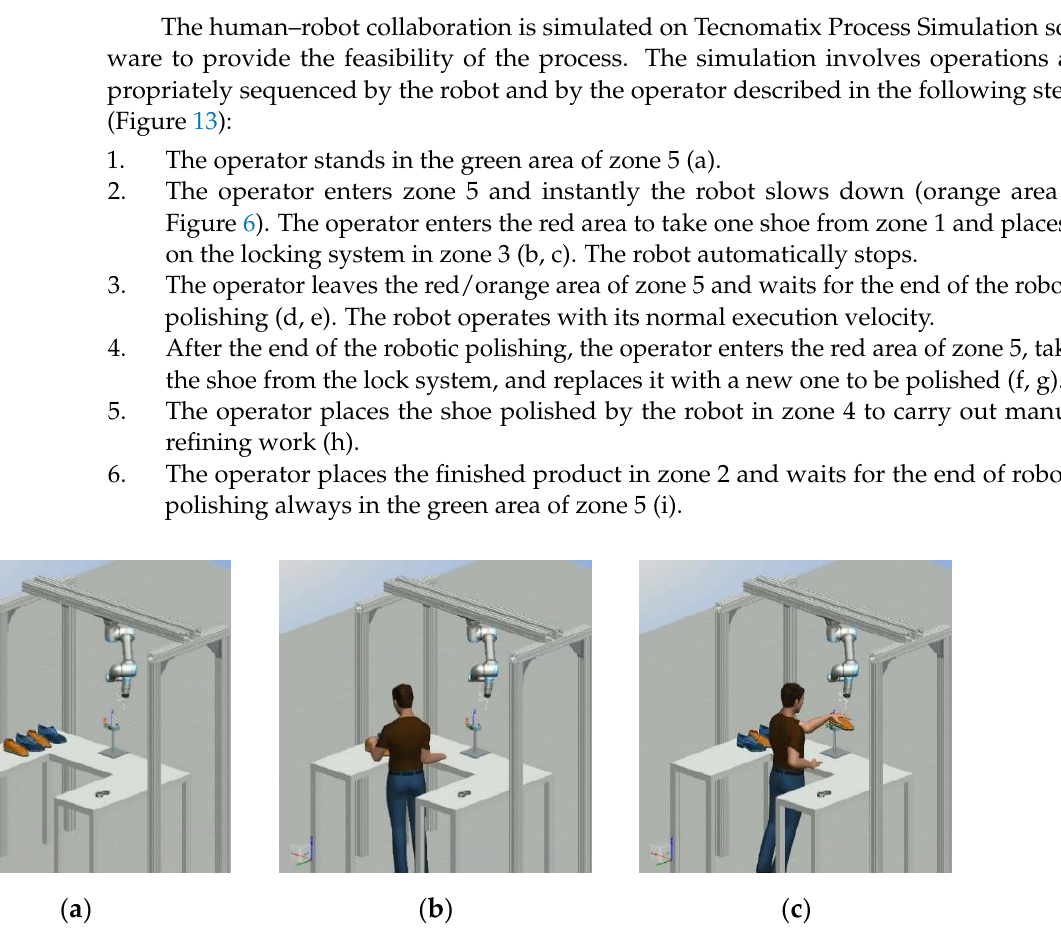
Figure 12. Prototype of the polishing tool.